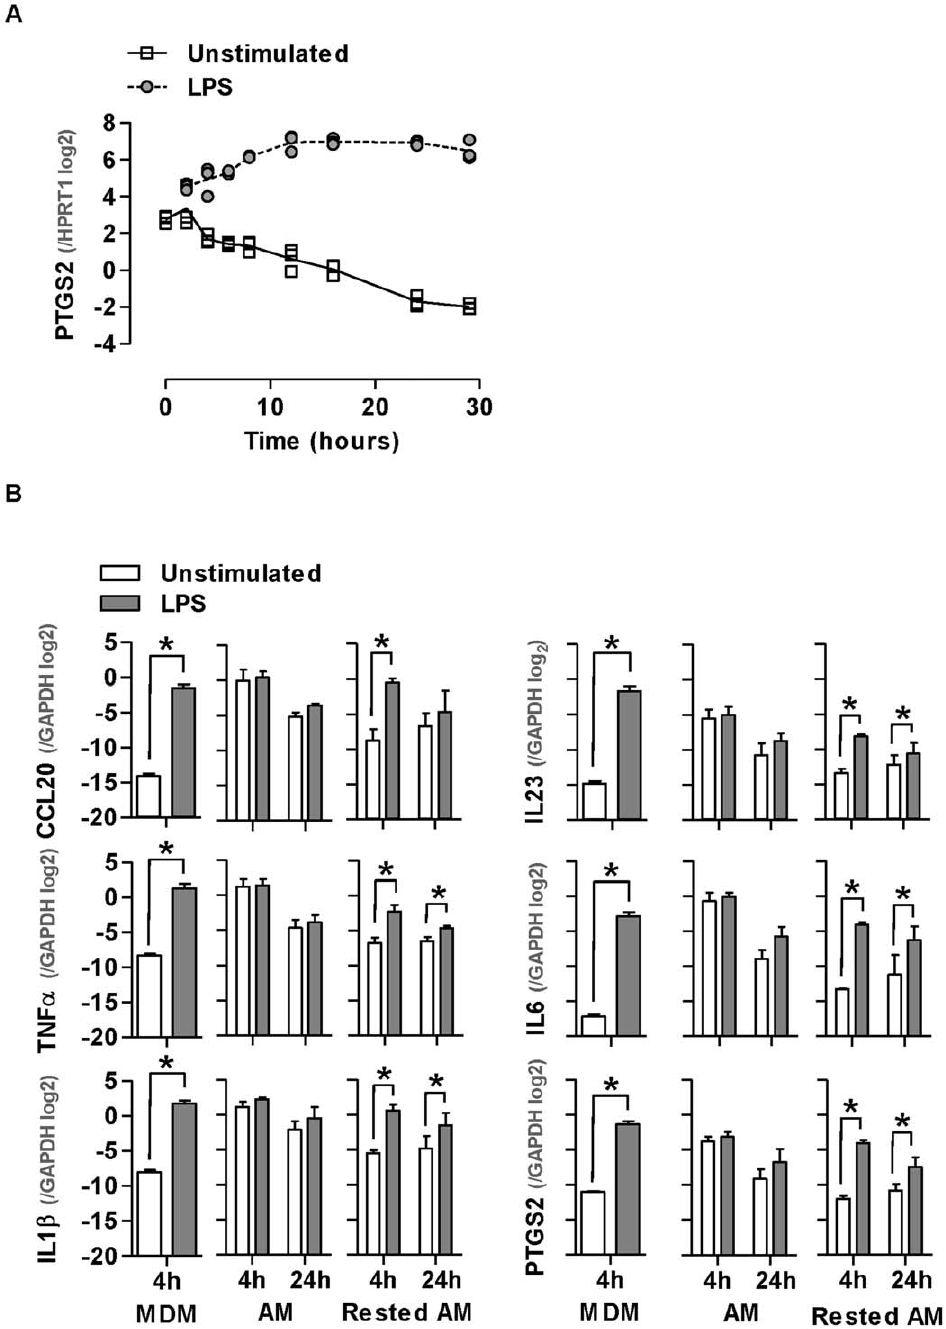
Figure 4. Reduction of AM inflammatory gene expression with time in culture. (A) AM show a significant reduction in PTGS2 expression over time (p , 0.0001, ANOVA). Data points represent technical replicates of measurements from one patient with DIP. (B) Selected gene expression changes identified by microarrays are validated by qPCR. Basal pro-inflammatory gene expression is reduced in AM which have been rested for 48 hours and upregulated following LPS stimulation. Bars represent mean 6 SEM for at least 4 separate experiments (*denotes p , 0.05, t-test). doi:10.1371/journal.pone.0040348.g004 as previously described [30]. T tests were used to identify significant gene expression differences (p , 0.05) between samples. Total RNA was purified from cell lysates collected in RLT Relative differences in transcriptional profiles were compared by buffer (Qiagen) using the RNEasy Mini kit (Qiagen). Human hierarchical clustering by Euclidean distance, using MultiExperi- universal standard reference RNA representing an equal mixture ment Viewer v4.6.0 and dendograms were created using Tree- of ten human cell lines was obtained from Stratagene. Samples View v1.6.6. DAVID functional annotation clustering was used to were processed for Agilent microarrays and data were normalised